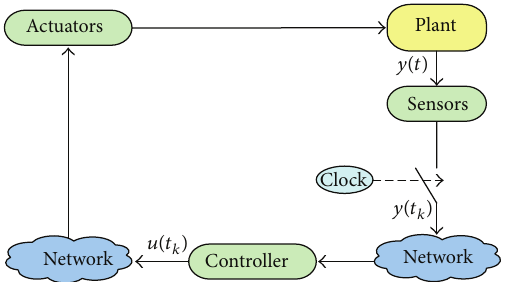
Figure 1: General configuration of NCSs with time-driven commu- nication.